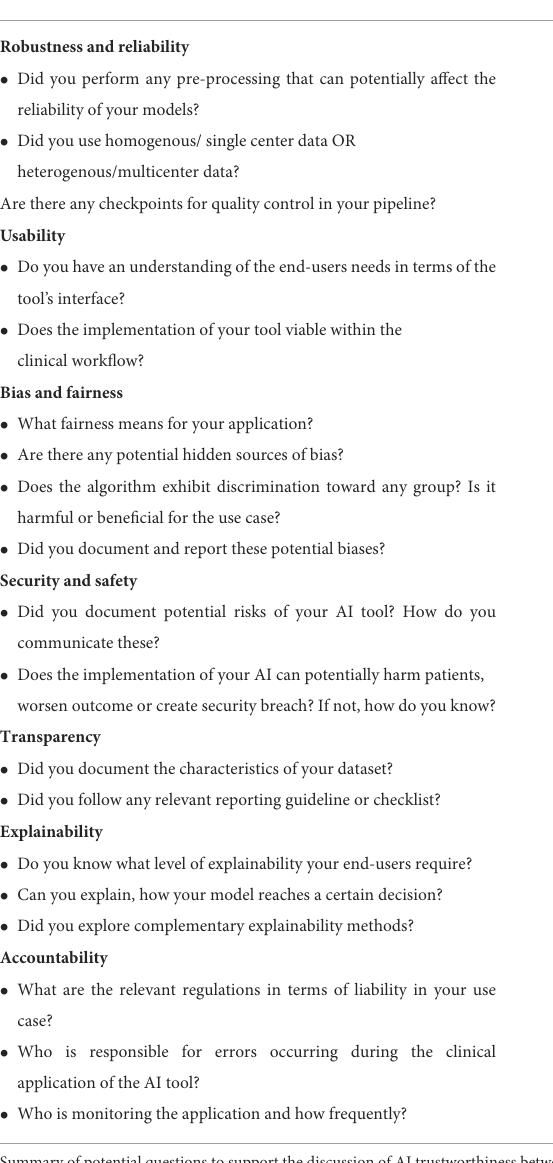
TABLE 2 Questions to promote discussion of AI trustworthiness between clinicians and technical